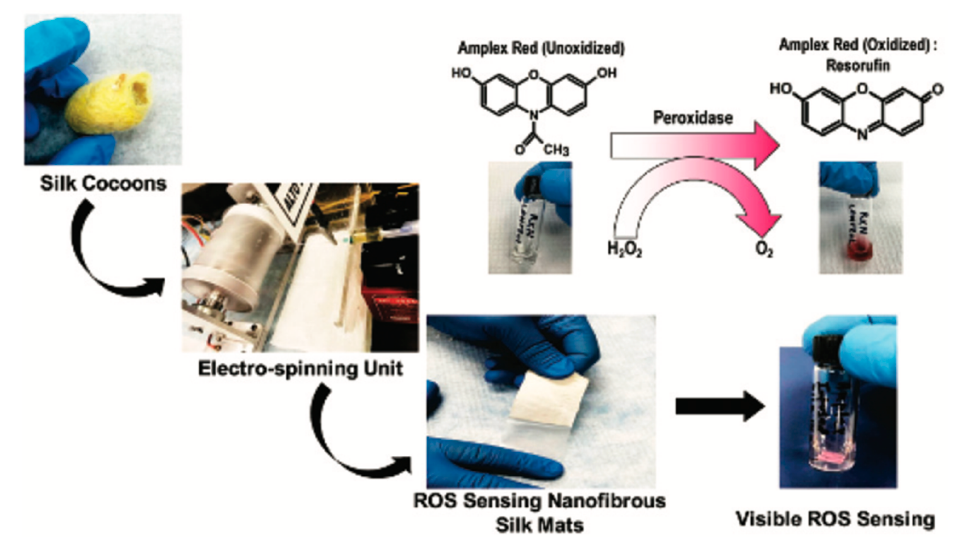
Figure 2. Colorimetric ROS detection. Reprinted with permission from Ref. [87]. 2020 Biomaterials Science.